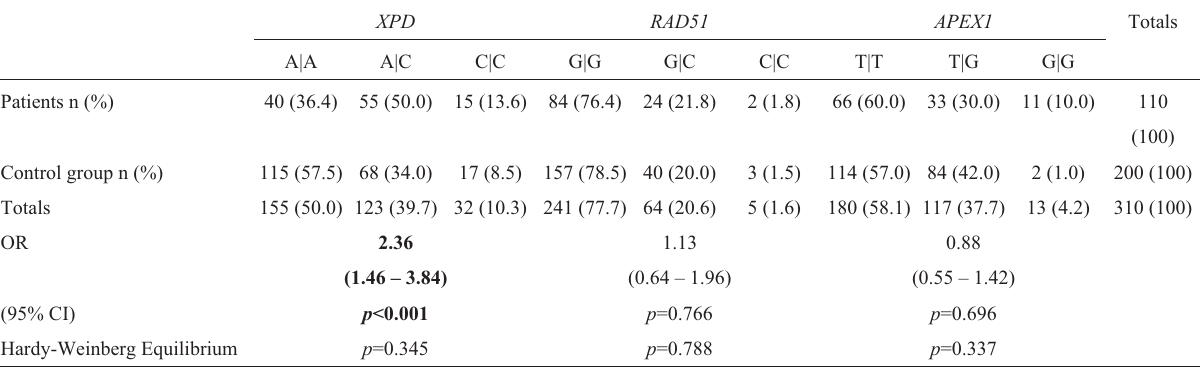
Table 3 - Genotypic frequencies of XPD , RAD51 and APEX1 genotypes in 110 prostate cancer patients and 200 controls. Results shown in bold were sta- tistically significant.